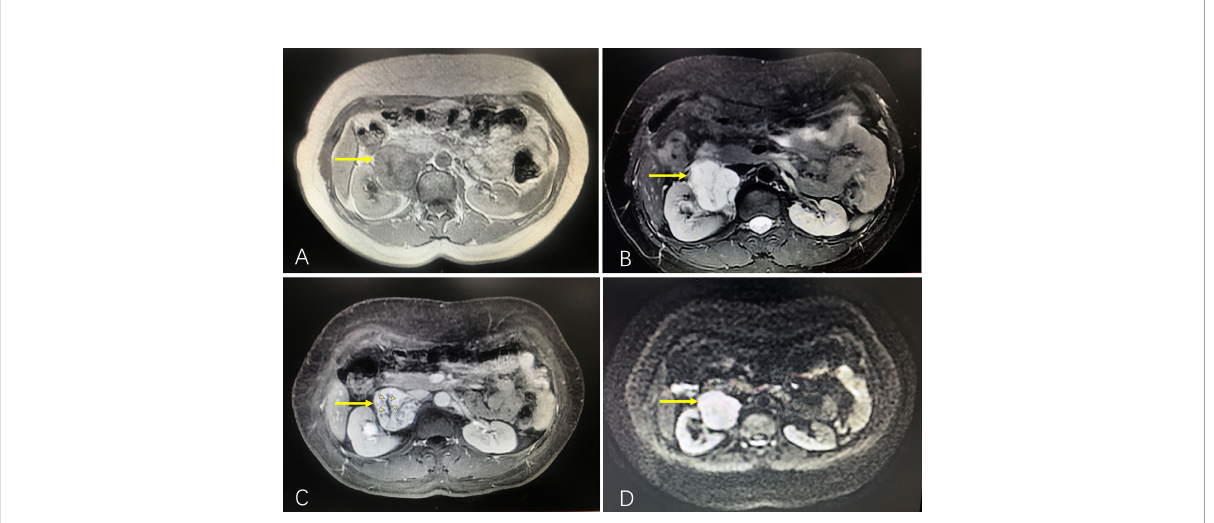
FIGURE 1 Abdominal MRI showing the mass compressing the right renal pelvis and ureter, and the right renal arteriovenous and inferior vena cava were also slightly compressed. (A) T1WI, low signal similar to the abdominal aorta (arrow). (B) T2WI, high signal for tumor (arrow). (C) Contrast- enhanced scan revealing that the tumor had an obvious enhancement with a central hypointense area (small arrow heads), and the fi lling of the contrast agent from the edge to the center was delayed. (D) DWI, high signal for the tumor